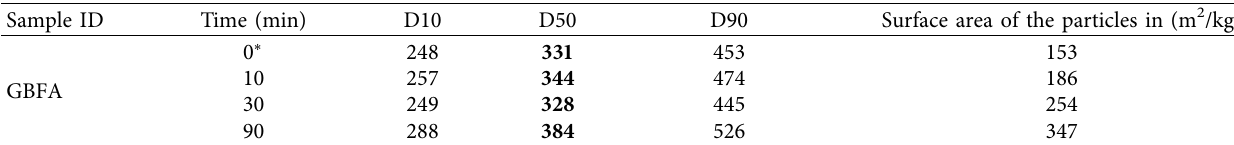
Table 5: Particle GBFS size.